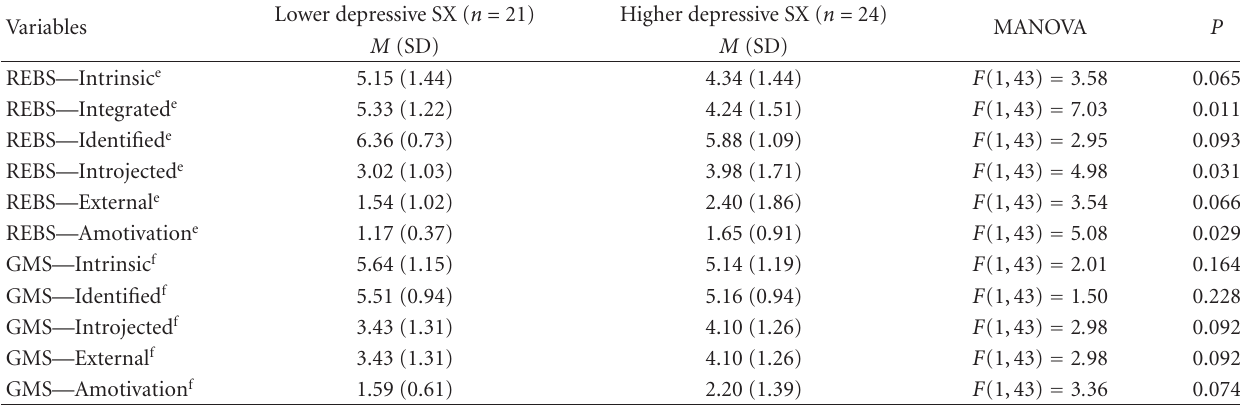
Table 3: Di ff erence between groups for motivational